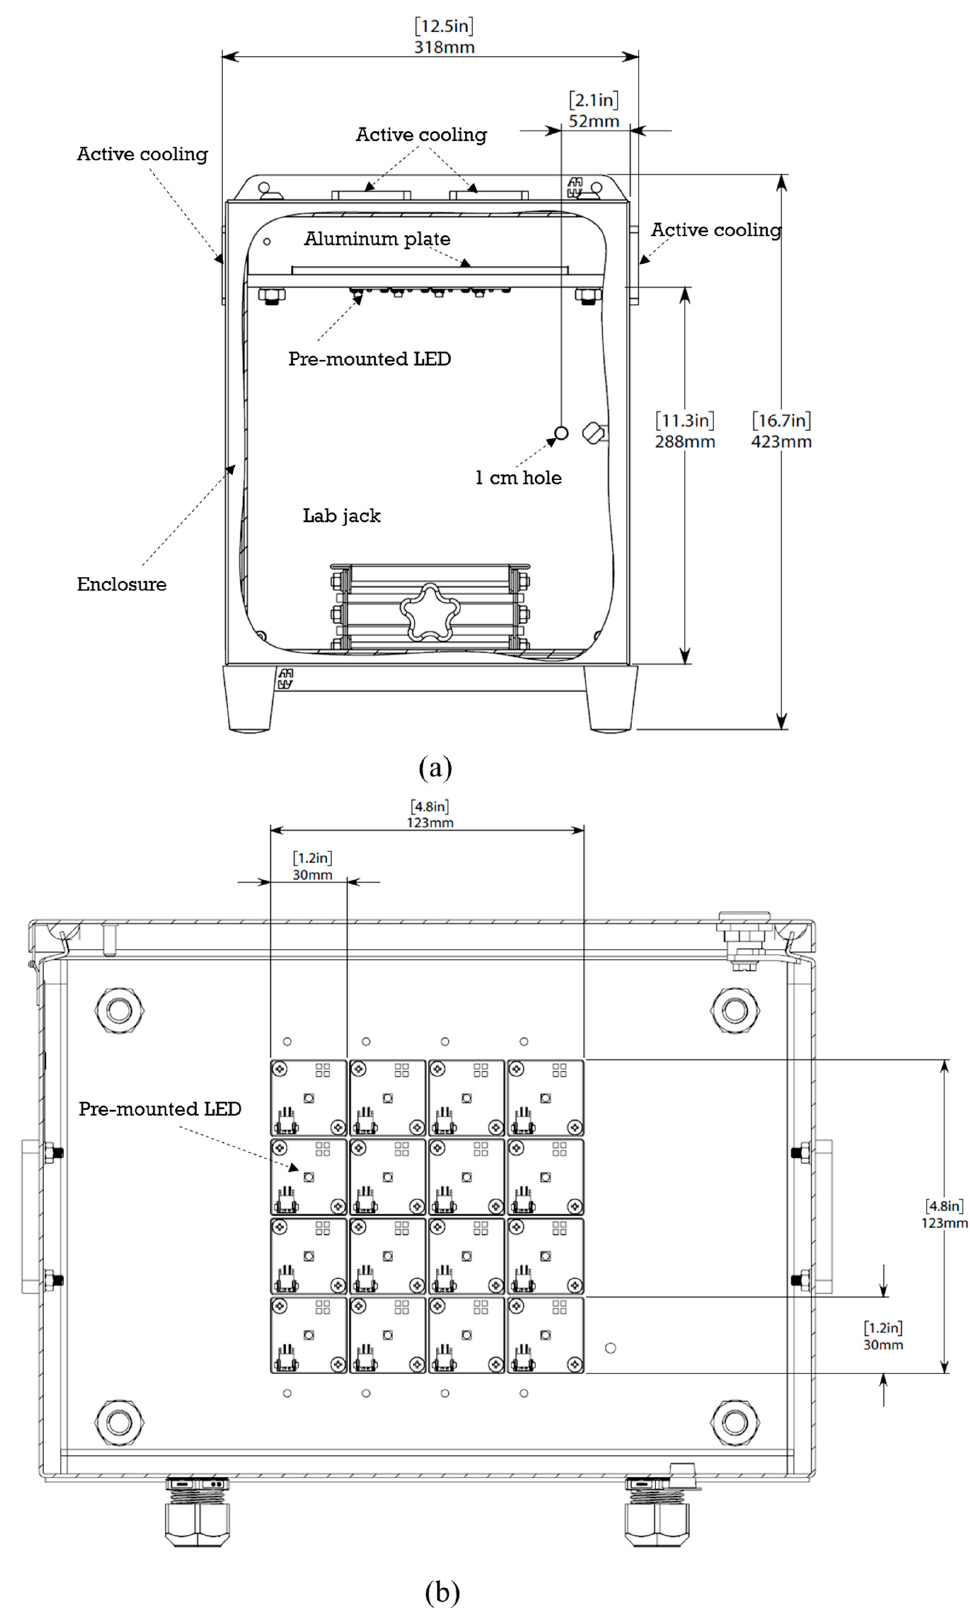
Figure 2. Schematics of LED photoreactor: ( a ) front view; ( b ) top view.